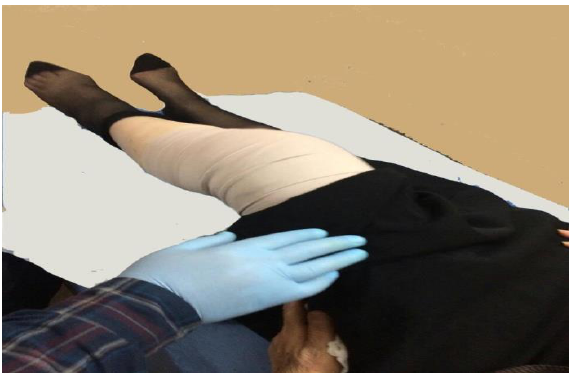
Figure 5. Bandaging of Knee joint.